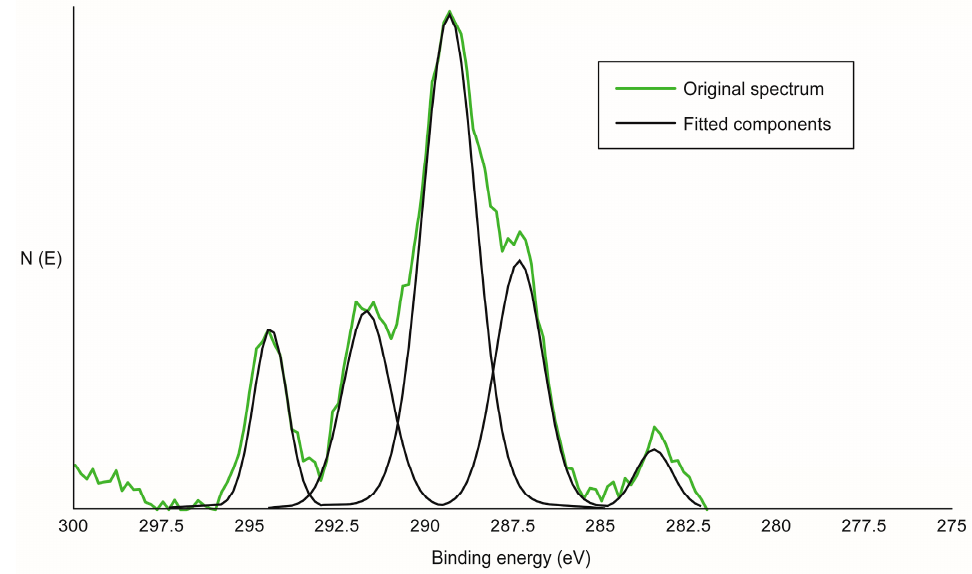
Figure 1. Carbon 1s spectrum of yellow-poplar treated with trifluoroacetic anhydride (TFA); the number of electrons measured (N (E)) plotted vs. binding energy (eV) [14].